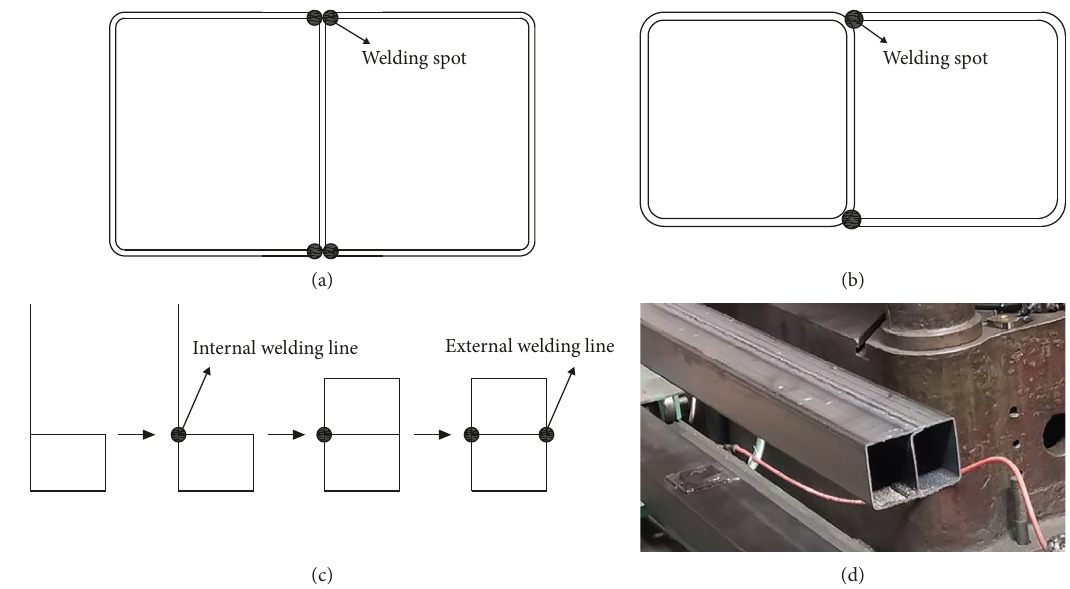
Figure 5: (a) “ 日 ” shape tube traditional forming method I. (b) “ 日 ” shape tube traditional forming method II. (c) New roll-forming method. (d) Product